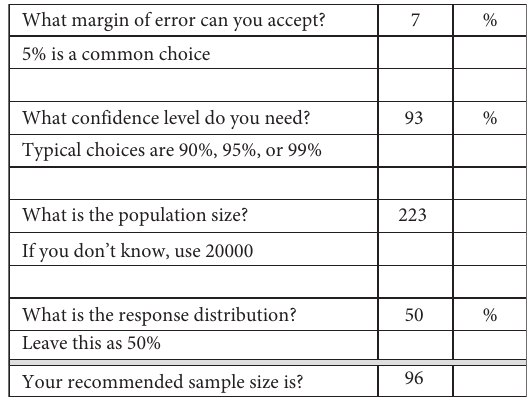
Figure 1: Sampling